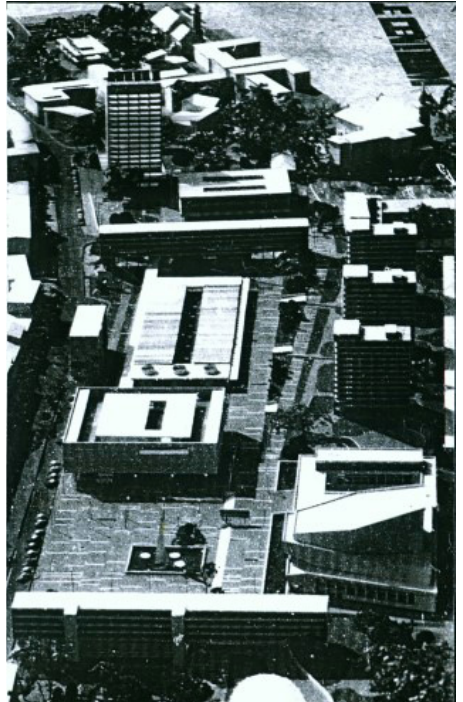
Figure 5. New centre of Opole. Model of the area by Zenon Prętczyński, Roman Tunikowski, and Ewa Cieszyńska. Source: “New centre of Opole” [ca.